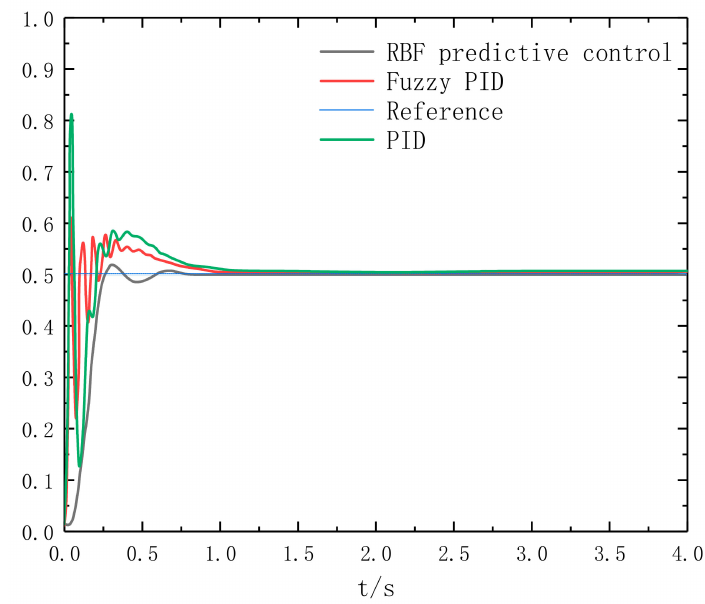
Figure 18. Physical verification comparison